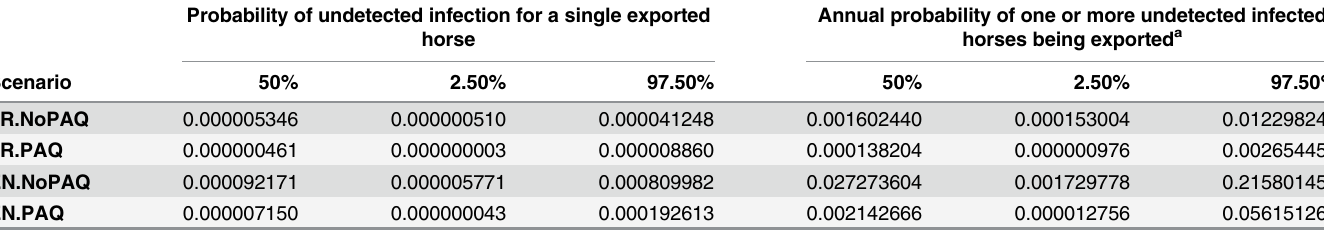
Table 5. Median and 95% predictive limits for probability of undetected AHS-infection for a single exported horse and annual probability of one or more undetected infected horses being exported. Probability of undetected infection for a single exported horse